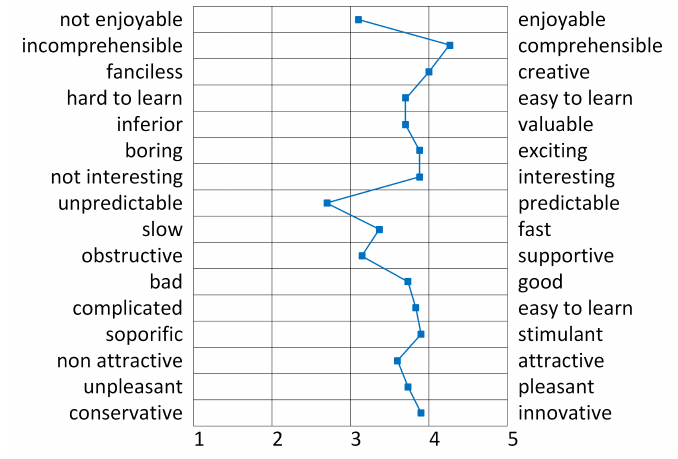
Figure 14. Evaluation results of bipolar assessments.